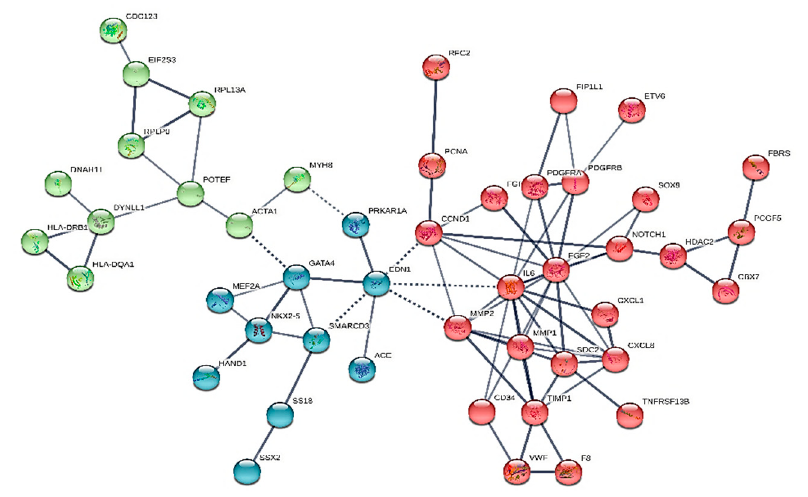
Figure 6. The heart synovial sarcoma interactome.